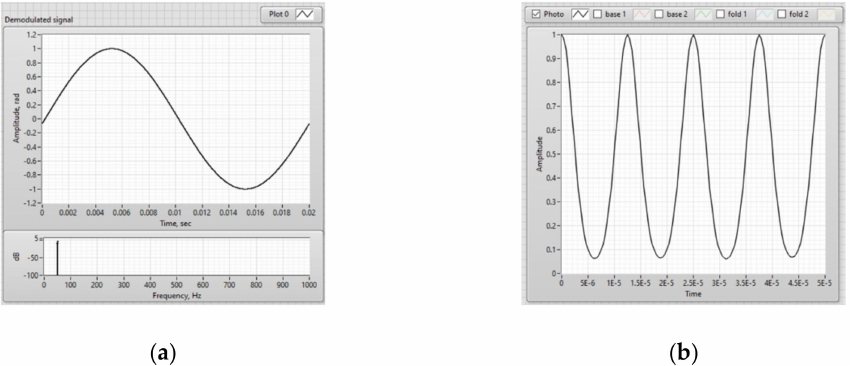
Figure 15. Results obtained during the FOCS modeling: ( a ) Demodulated signal and its spectrum; ( b ) Interference signal.